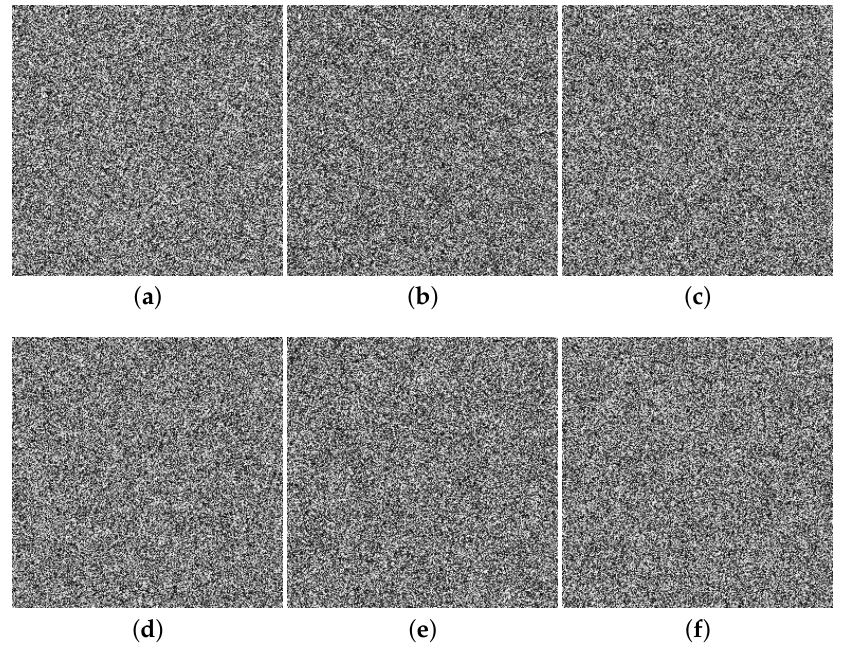
Figure 8. Result of encryption-procedure employed on standard images: ( a ) aerial; ( b ) lena; ( c ) cam- eraman; ( d ) jet; ( e ) lake; ( f )